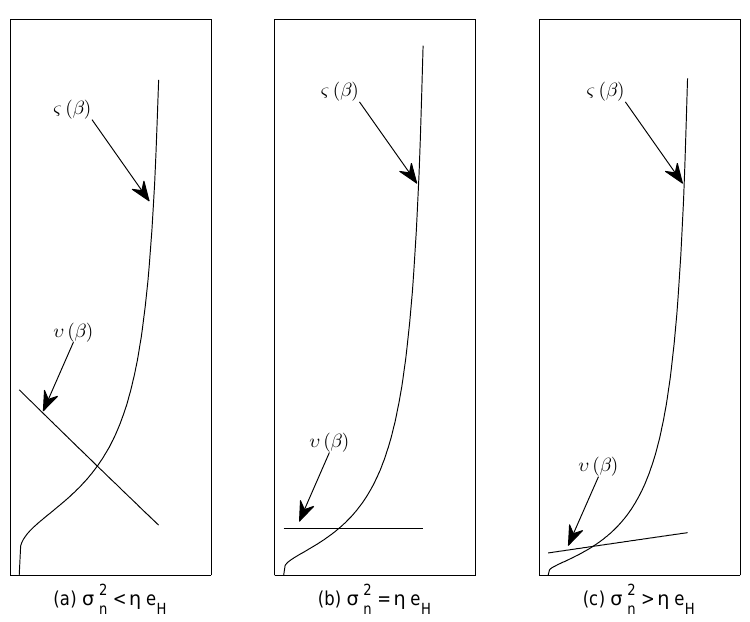
Figure A1. Illustration of ς ( β ) and υ ( β ) versus β over the range β 1 (cid:54) β (cid:54) β 2